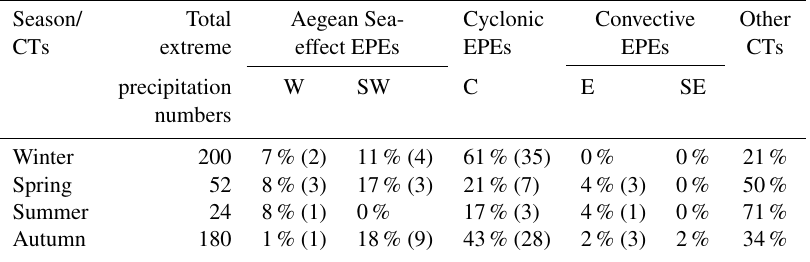
Table 2. Seasonal total extreme precipitation numbers over the Aegean considering 46 stations and their percentage frequency distribution according to the Aegean Sea effect, cyclonic, and convective precipitation types for the period 2006–2015. The total number of the days with EPEs are shown in